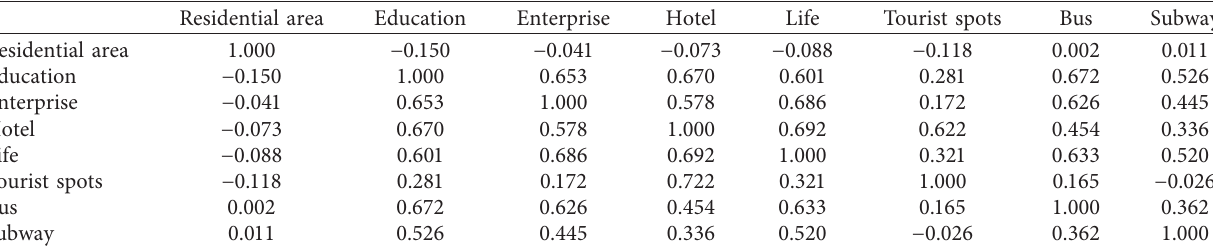
Figure 5: Distributions of subway and bus stations in Hangzhou, China. (a) Subway stations. (b) Bus stations. Table 2: Pearson correlation coefficients between explanatory